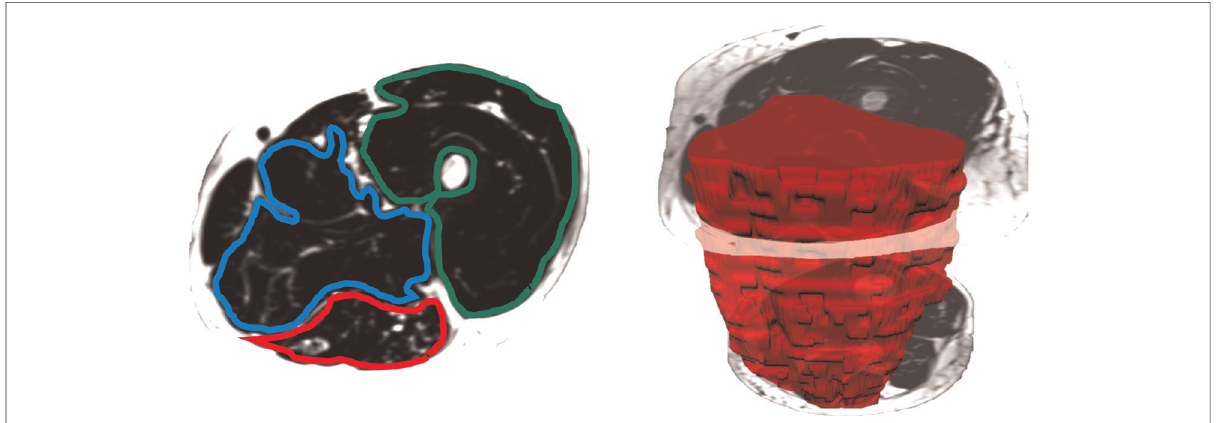
FIGURE 2 Left: One participants ’ fat image of the left thigh, with muscle regions of interest contoured (blue: adductors, green: quadriceps, red: hamstrings). Muscle fat in fi ltration was observed within each region of interest. Right: Muscle volumes were created by multiplying the cross-sectional area at each slice by the slice thickness (hamstring volume depicted in